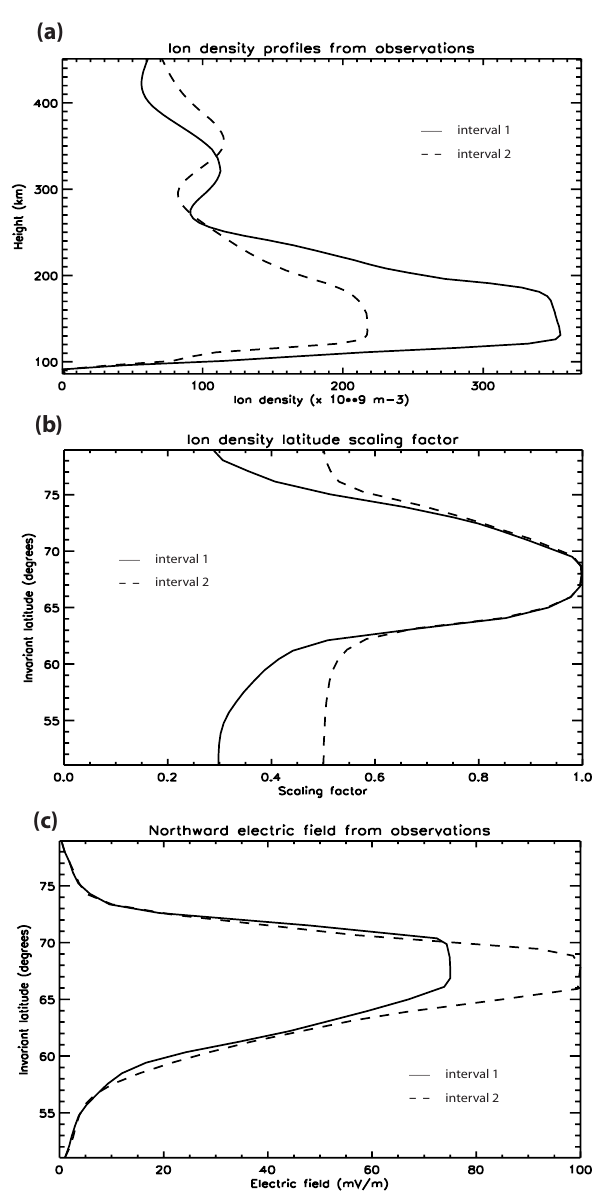
Fig. 3. Ion density and electic field structures used in the simula- tions, for the first and second intervals, inferred from the 28 Febru- ary observations (a) ion density profile (b) latitude scaling factor for the ion density (c) northwards electric